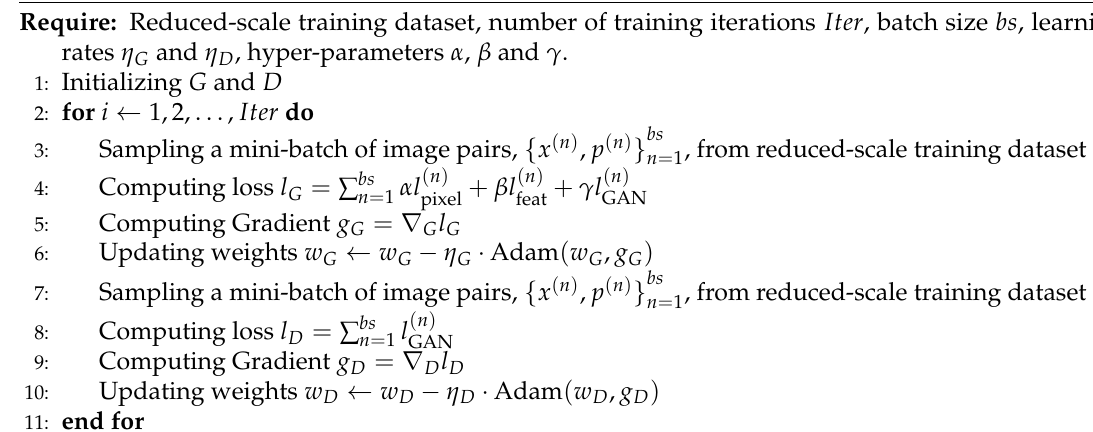
Algorithm 2 Reduced-scale SPSF training